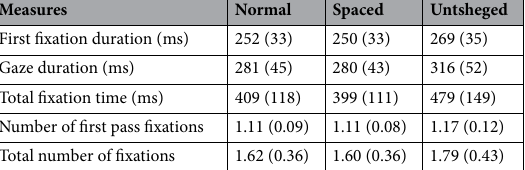
Table 3. Means (and standard deviations) of eye movement measures for local